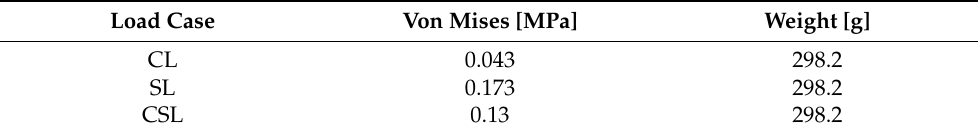
Table 4. Simulation results of the 2D rough structure for each load case.